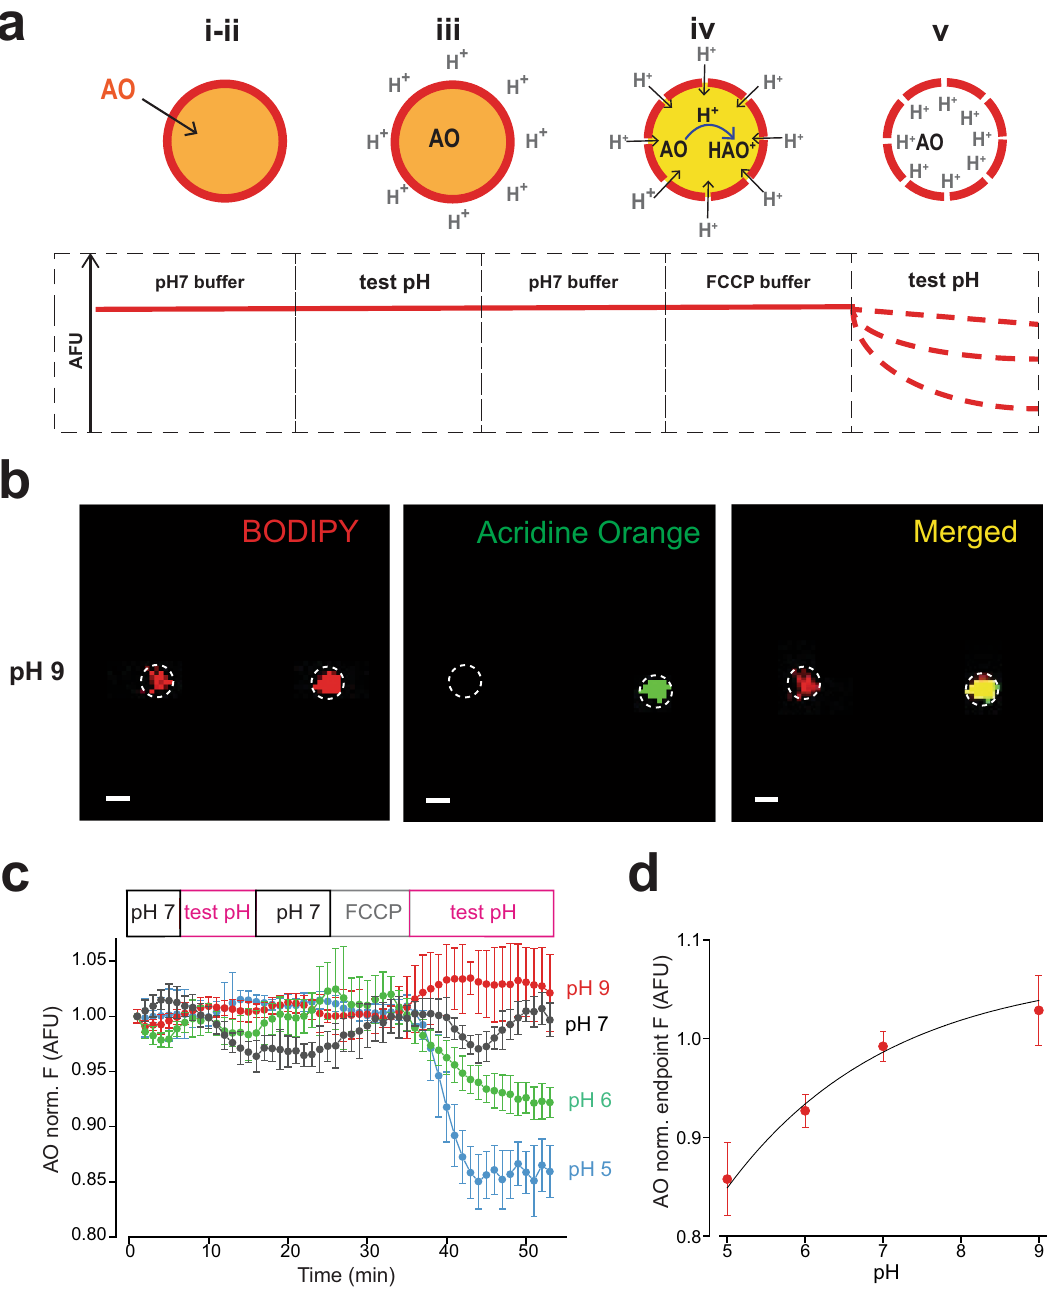
Fig. 5 pH measurements in individual EVs. a Schematic of the procedure used for manipulation of internal pH inside AO-equilibrated vesicles. (i) Cell- permeant fl uorescent AO in a vesicle in pH 7.4 solution. (ii) Lack of change in fl uorescence of the vesicle following exposure to acidic pH solution indicates vesicle competency. (iii) Change of external solution from low pH to a neutral buffer without accompanying fl uorescent change veri fi es membrane stabilization. (iv) Treatment with the protonophore FCCP (100 μ M) in neutral buffer, followed by (v) exposure to acidic pH buffer, leading to quenching AO fl uorescence signal. b Representative confocal microscopic image of vesicles equilibrated with 4 µ M AO in buffer, pH 9, (scale bar 1 µ m). Although all membranous structures were labeled with Bodipy-TR (red color, left panel), only intact vesicles loaded with AO (green fl uorescence, middle panel), and only those (merged yellow color, right panel) were chosen for subsequent experimental observations. c Data correlating internal AO fl uorescence signal with changes in vesicular pH. Freshly isolated BAL vesicles captured on NPN membrane were equilibrated in a micro fl uidic device with 4 µ M AO solution in pH 7.4 buffer. Changes in the intra-vesicular AO fl uorescence signal in response to changes in solution pH from 5 to 9 were recorded over time and analyzed with respect to the basal signal of each vesicle at pH 7.4 (normalized to 1). At pH 5, data were obtained from n = 233 individual (viable) vesicles from 3 independent experiments. For pH 6, a total of n = 263 individual, viable vesicles from 4 independent experiments were analyzed. An average fl uorescence from n = 398 individual vesicles from 6 independent experiments was calculated for pH 7. Finally, for pH 9, n = 243 individual vesicles from 4 independent experiments were used. Data were adjacent averaged with a window of 5 points. d Dynamic range of intra-vesicular AO fl uorescence signal from single vesicles. Each data point represents an average ± SEM of AO fl uorescence in the last 5 min of the experiment depicted in Fig. 3c. The data were fi t with a single exponential equation ( y = y + A * e R 0 (cid:1) X 0